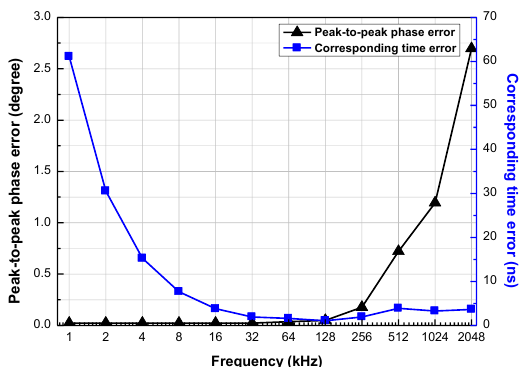
Figure 14. Peak-to-peak phase error and corresponding time error for f in from 1 kHz to 2.048 MHz.